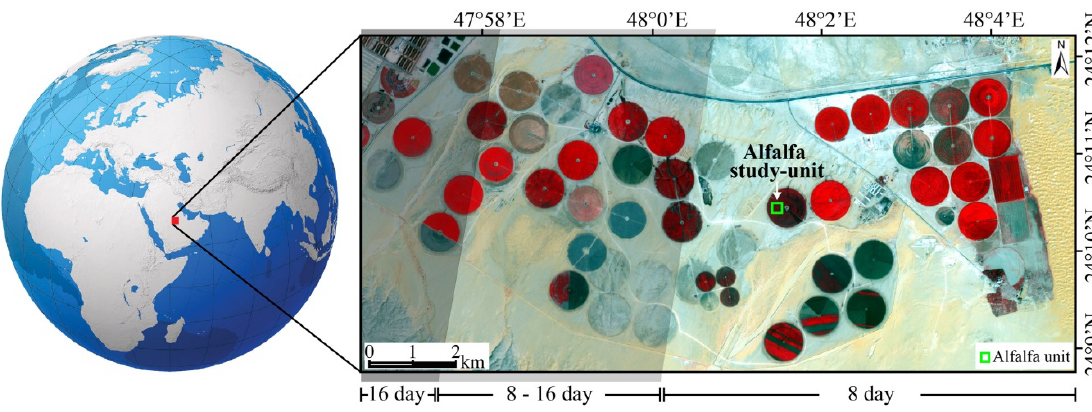
Figure 1. Domain and geographic location of the studied agricultural farming area. The image is a false color representation of ~3 m resolution CubeSat RGB + NIR imagery. Zones with an 8-day, 8–16-day, and 16-day Landsat revisit frequency are overplotted. The alfalfa study unit (180 × 180 m 2 ) used for extracting time series information is also indicated.